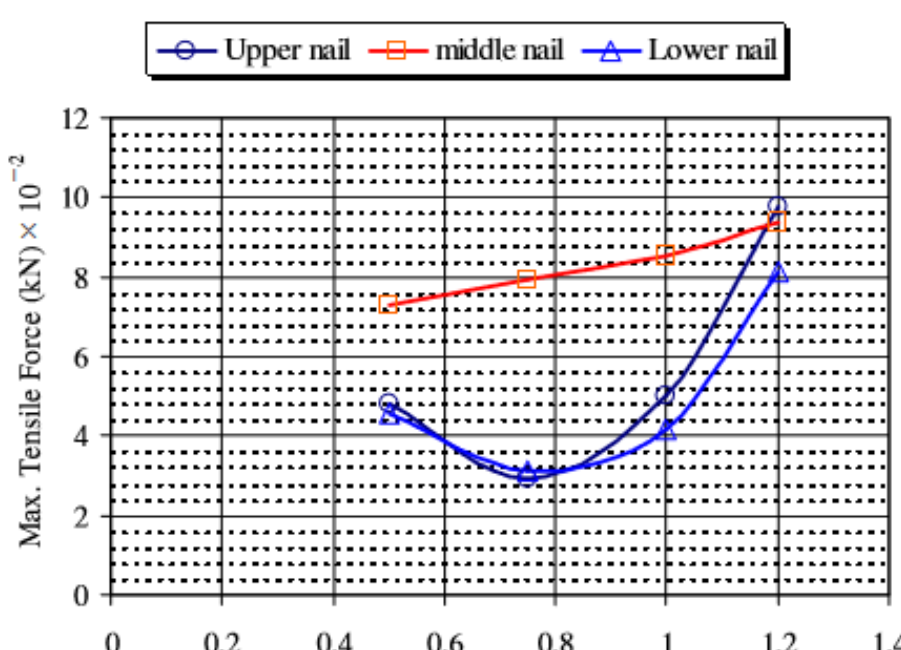
Figure 9. Effect of nail length on maximum tensile force in the nail at different levels.